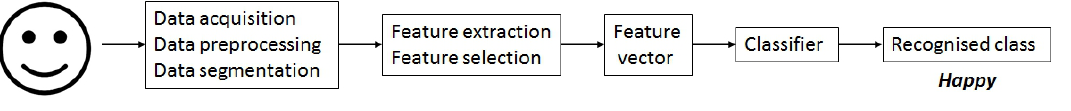
Figure 3. General emotion recognition